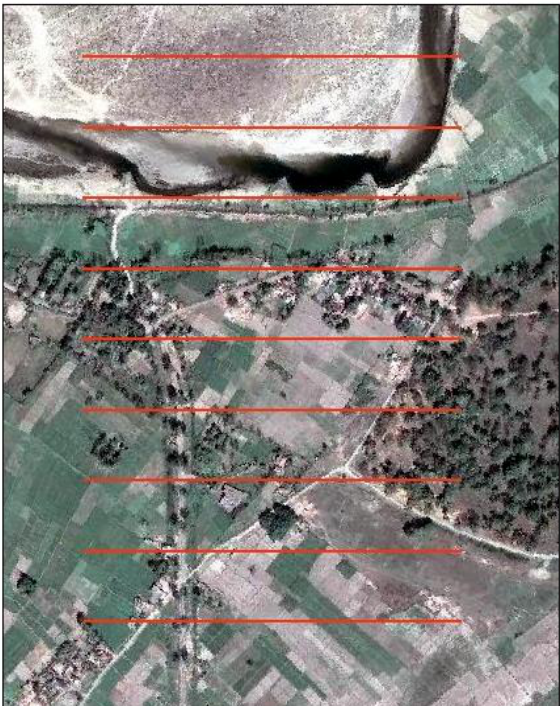
Figure 1. Flight plan. Axis of flight lines are marked